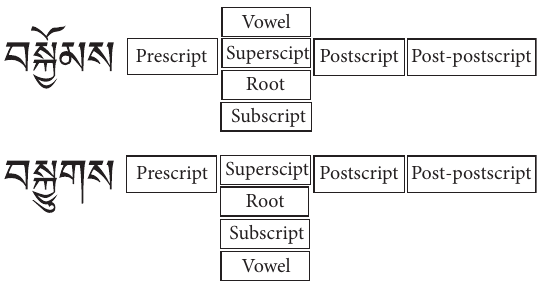
Figure 3: The structure of Tibetan